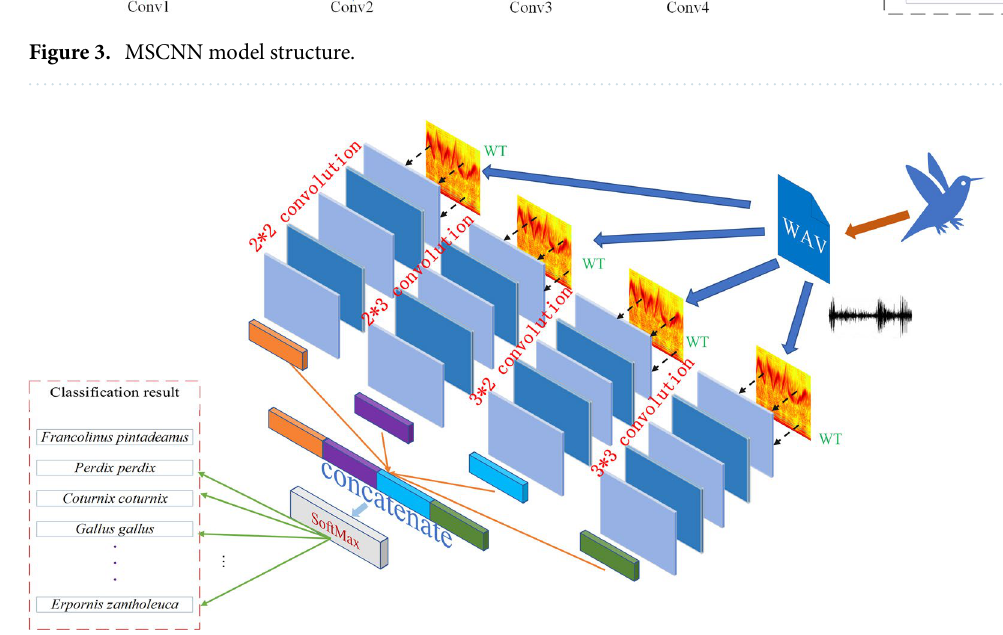
Figure 4. EMSCNN model